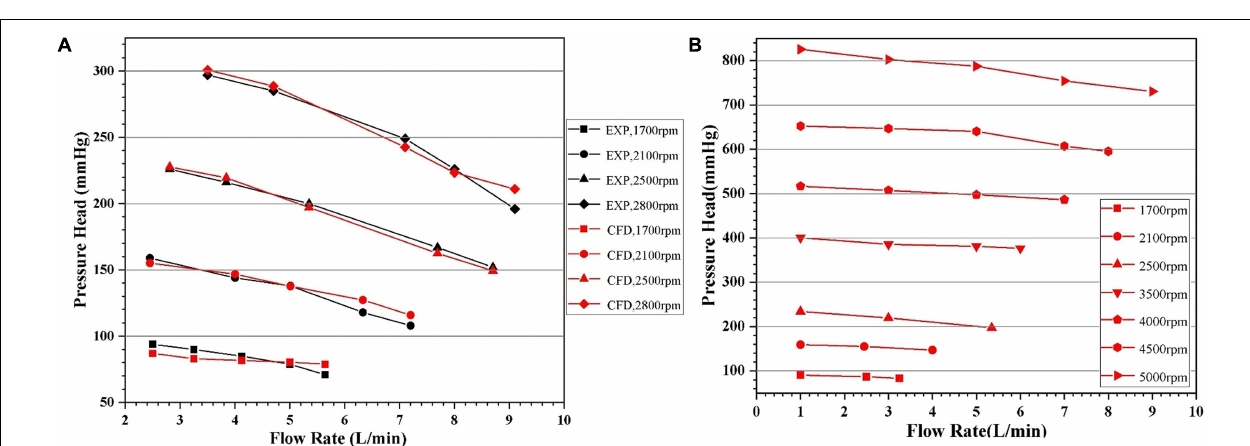
being 15 mm (model 3) and 13.5 mm (model 4),